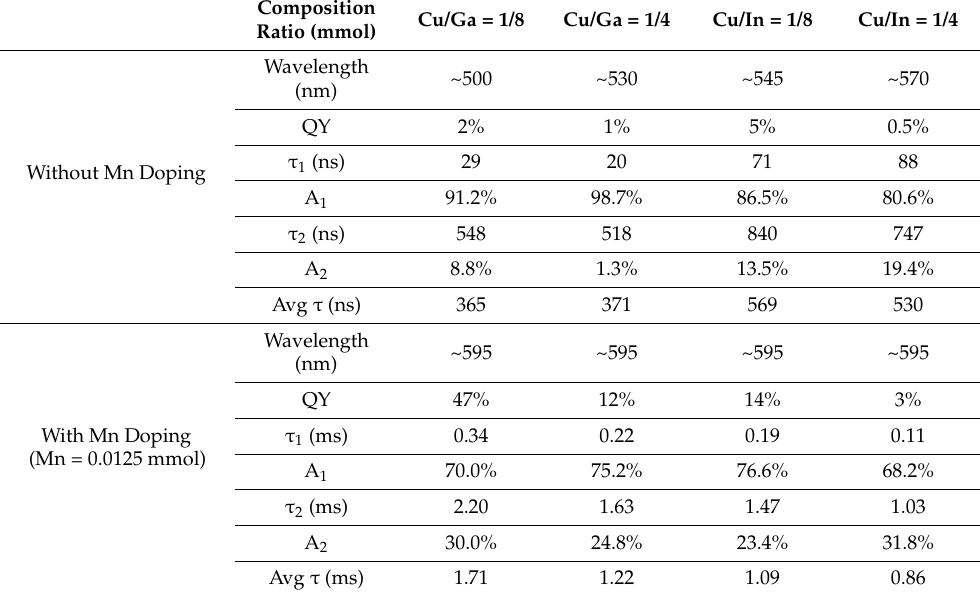
Table 1. Effect of host NC on optical properties of Mn-doped NCs. Composition Cu/Ga = 1/8 Cu/Ga = 1/4 Ratio (mmol)